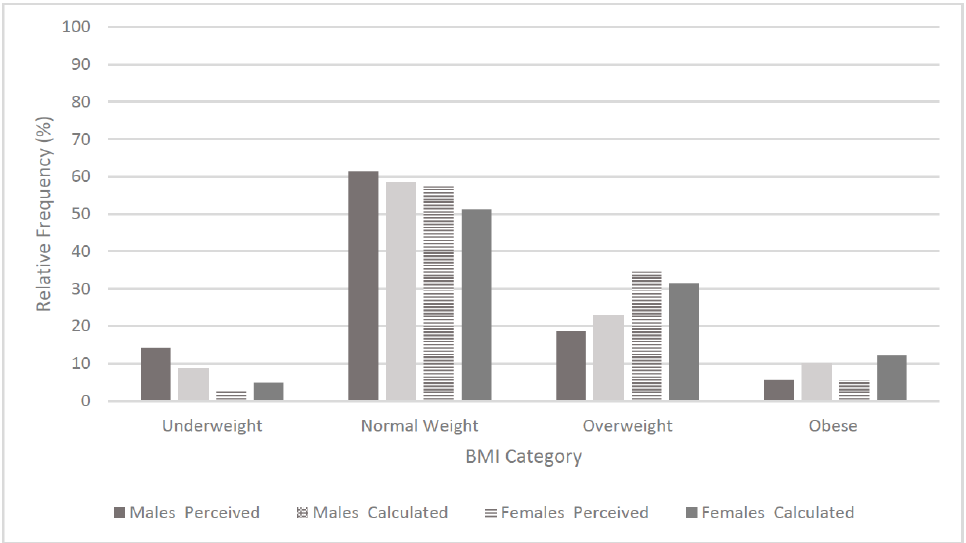
Figure 2. Received versus calculated BMI category by gender at T3.